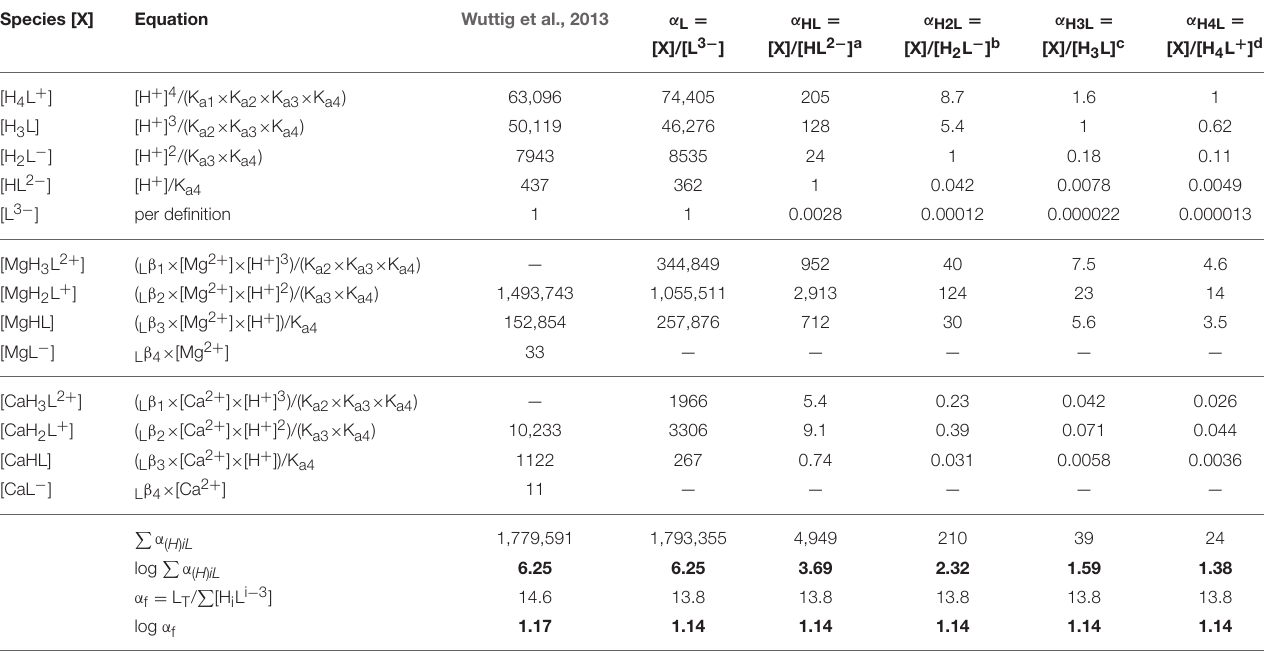
TABLE 9 | Calculation of the side-reaction coefficient of DFOB in seawater, using the data from Table 8. Species [X] Equation Wuttig et al., 2013 α L